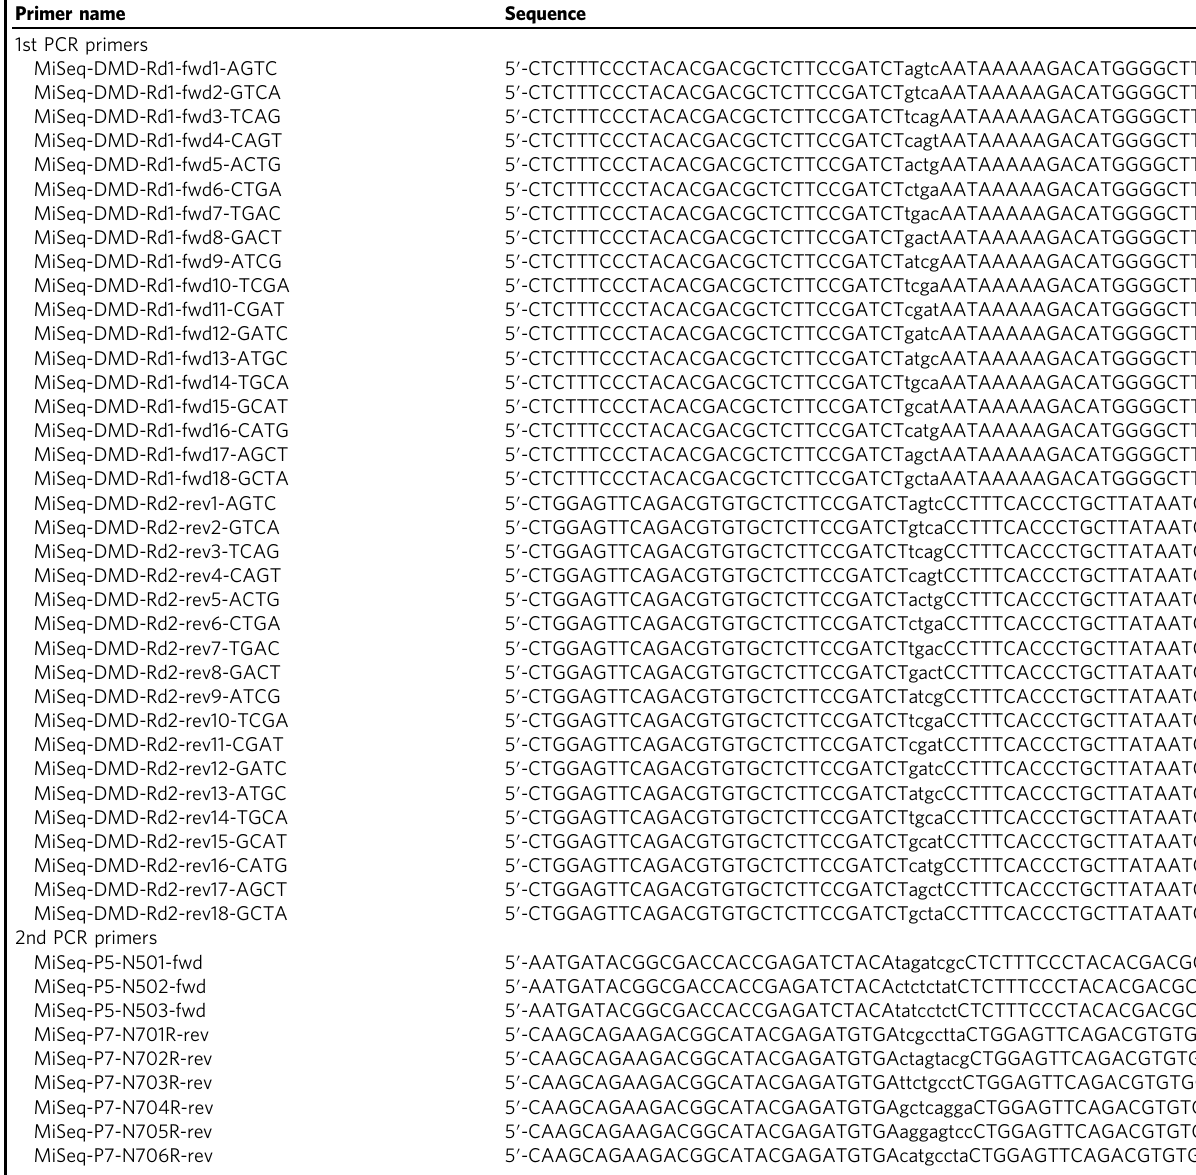
Table 6 Primers used for deep sequencing